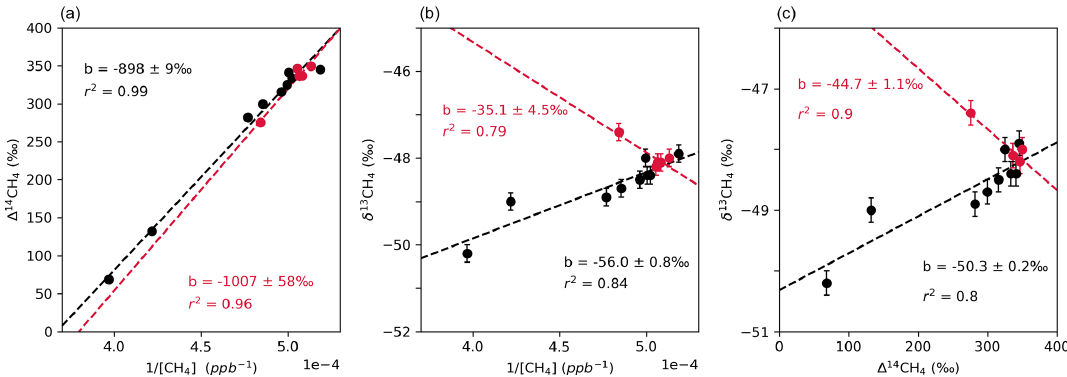
Figure 3. Keeling plots of (a) CH 4 and (cid:49) 14 CH 4 , (b) CH 4 and δ 13 CH 4 , and (c) plot of δ 13 CH 4 and (cid:49) 14 CH 4 in air samples collected from 20 to 23 August (south) in black ( n = 9) and from 16 to 20 August (north) in red ( n = 5). In (a) and (b) , the intercept of the Keeling plot b indicates the isotopic signature of the CH 4 source. In panel (c) , the intercept b is interpreted as the δ 13 C value of fossil CH 4